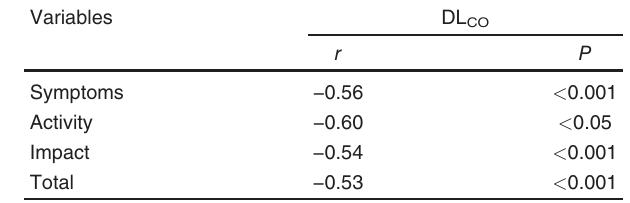
Table 6 Correlation between high-resolution computed tomography and International Physical Activity Questionnaire